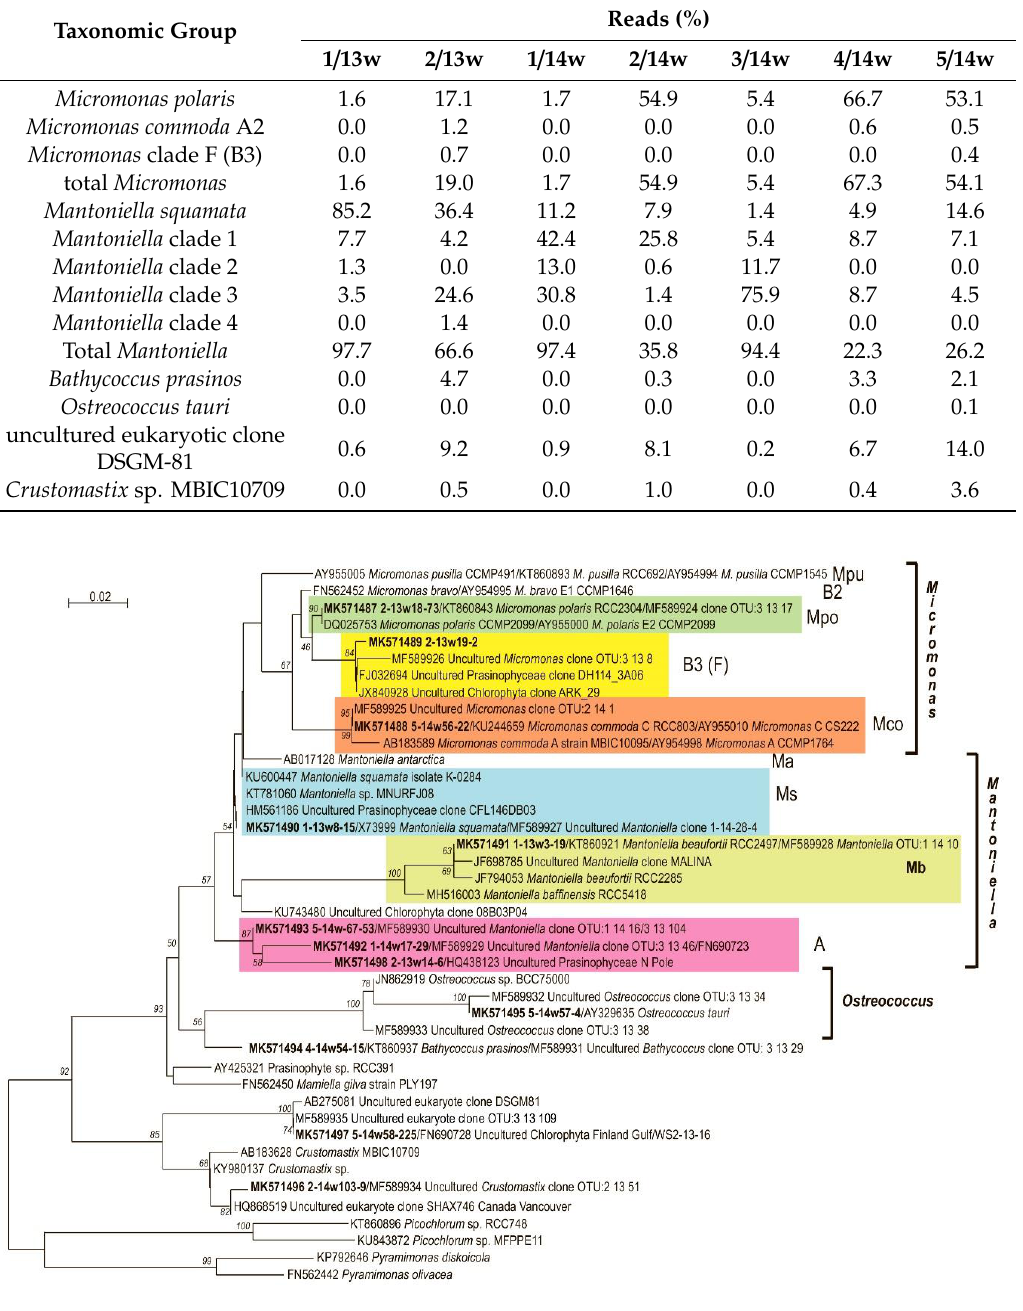
Figure 3. Phylogenetic tree of revealed Mamiellophyceae OTUs and Genbank reference sequences constructed from the V4 region of the 18S rRNA gene sequences by the maximum likelihood method. Bootstrap supporting values > 0.5 are indicated. The scale is a number of nucleotide substitutions per site. Clades are designated according to Tragin and Vaulot (2019) [43] and Belevich et al. (2018)